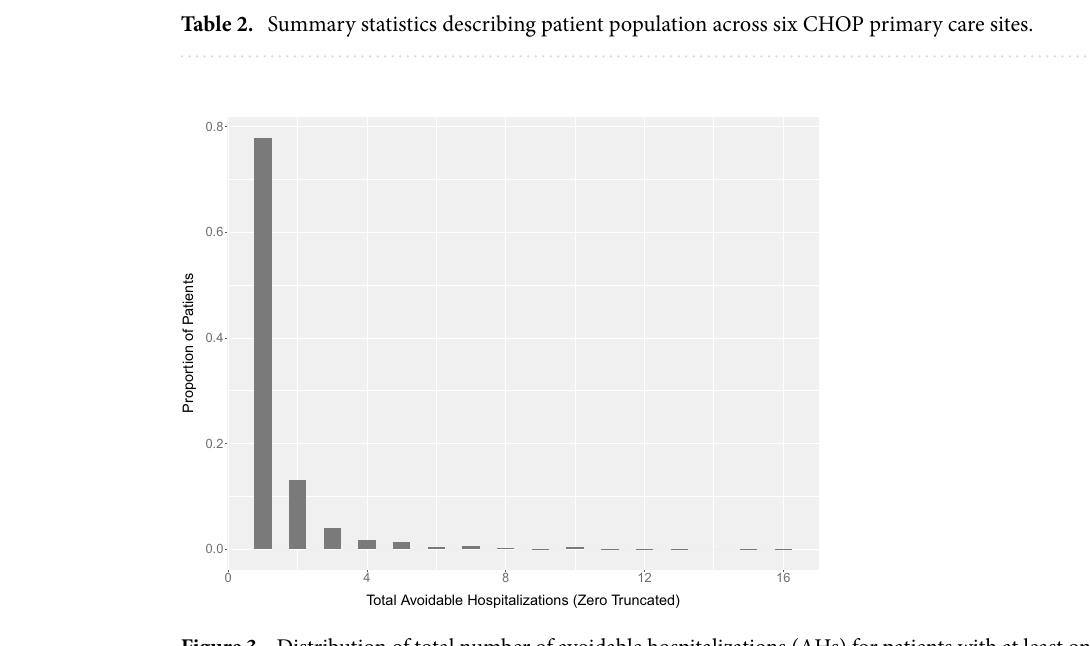
Figure 3. Distribution of total number of avoidable hospitalizations (AHs) for patients with at least one AH in CHOP data